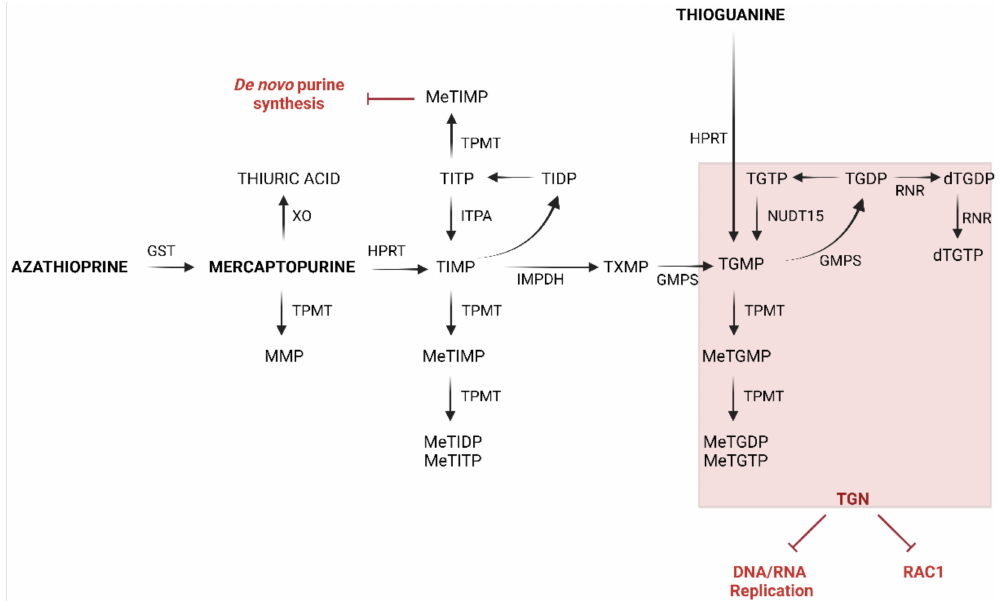
Figure 1. Thiopurine pathways. Compounds: MMP: methylmercaptopurine, TIMP: thioinosine monophosphate, TIDP: thioinosine diphosphate, TITP: thioinosine triphosphate, TXMP: thioxantho- sine monophosphate, TGMP: thioguanosine monophosphate, TGDP: thioguanosine diphosphate, TGTP: thioguanosine triphosphate. Enzymes: GST: glutathione S-transferase, GMPS: